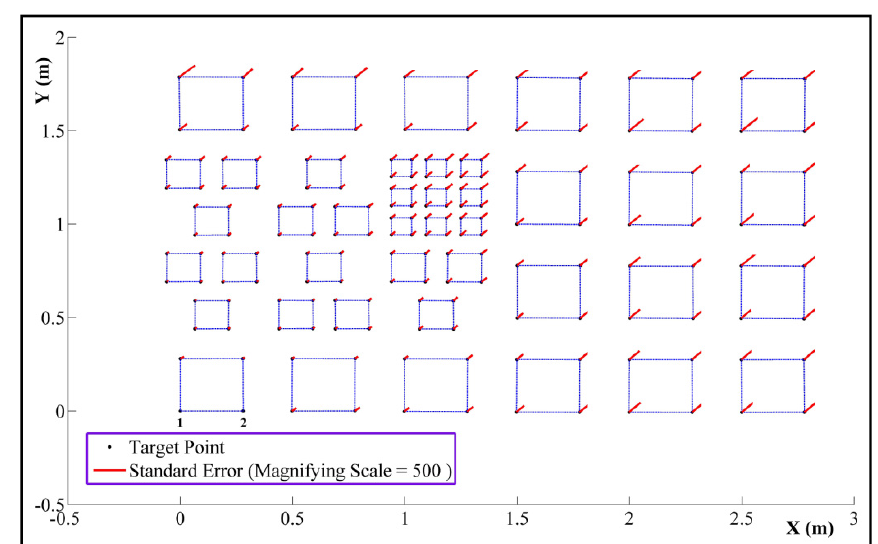
Figure 6. Target coordinates in object